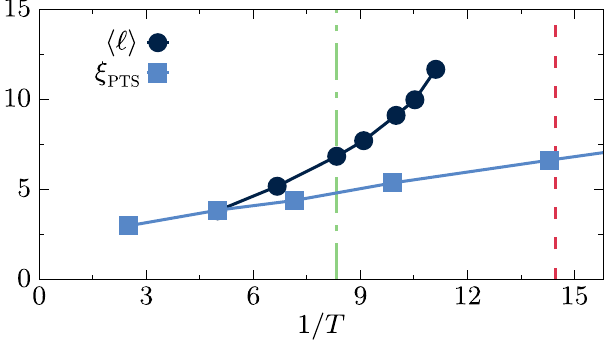
FIG. 21. Decoupling of static and dynamic length scales in 2D supercooled liquids. The dynamic length scale is the average chord length h l i of dynamic heterogeneities at C point-to-set length scale ξ crossover radius from Ref. [18]. Mode-coupling crossover temperature (dashed-dotted line) and glass transition temperature (dashed) are